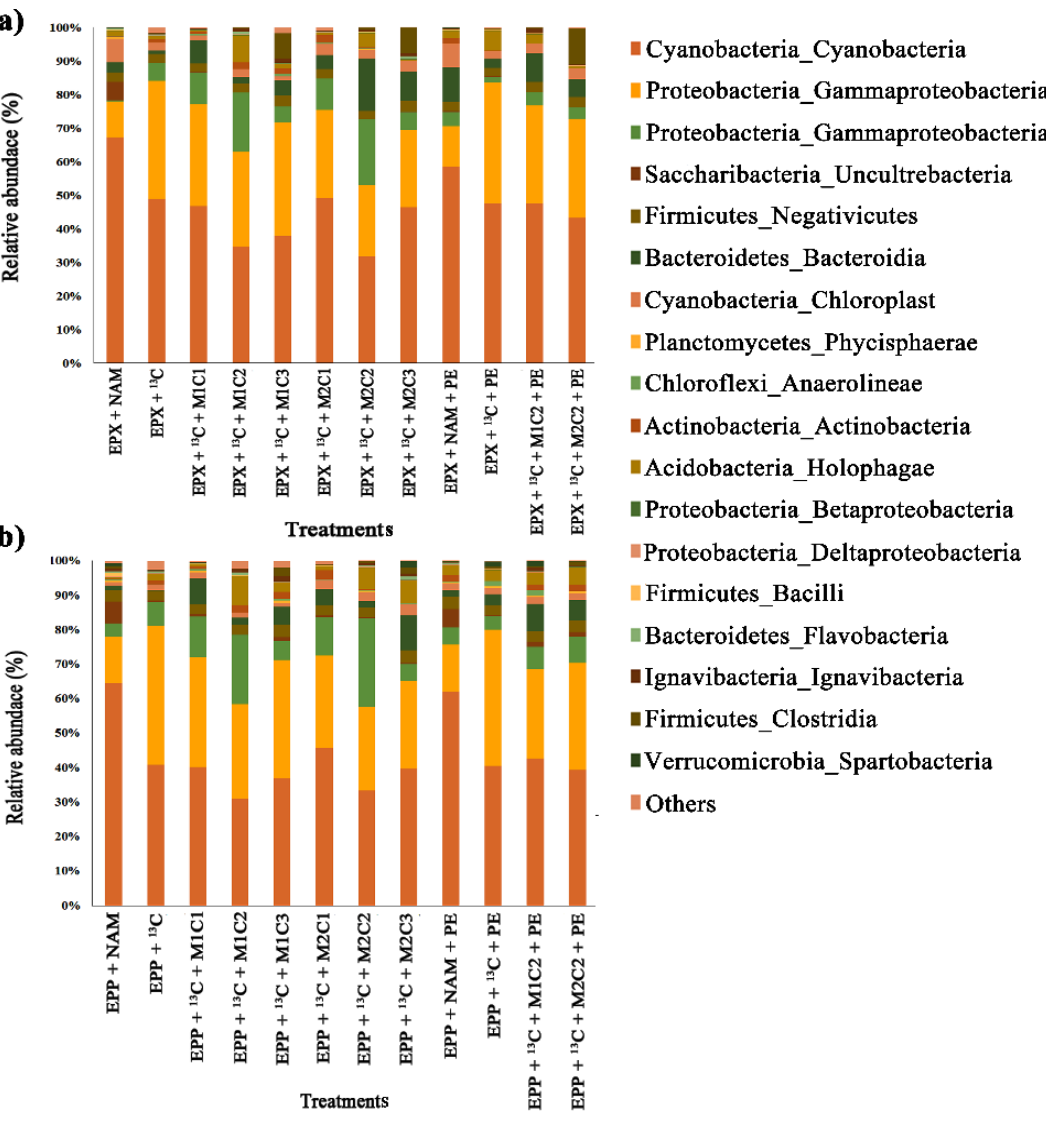
Figure 9. High-throughput 16S rRNA gene sequencing from total DNA showing the relative abundance of different phylum and classes in ( a ) epixylon and ( b ) epiphyton of all low and high methane treatments derived from 13 C fraction of DNA obtained by gradient centrifugation of treatments with Pb 2+ (M1) and Cd 2+ (M2) at concentration of 50 mg L − 1 (C2) and in combination with PE.